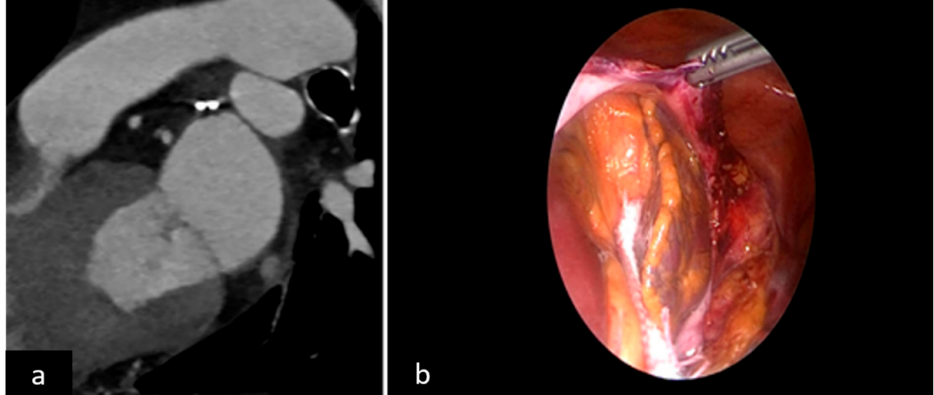
Figure 3. ( a ) 2D CT scan epicardial closure, ( b ) surgical